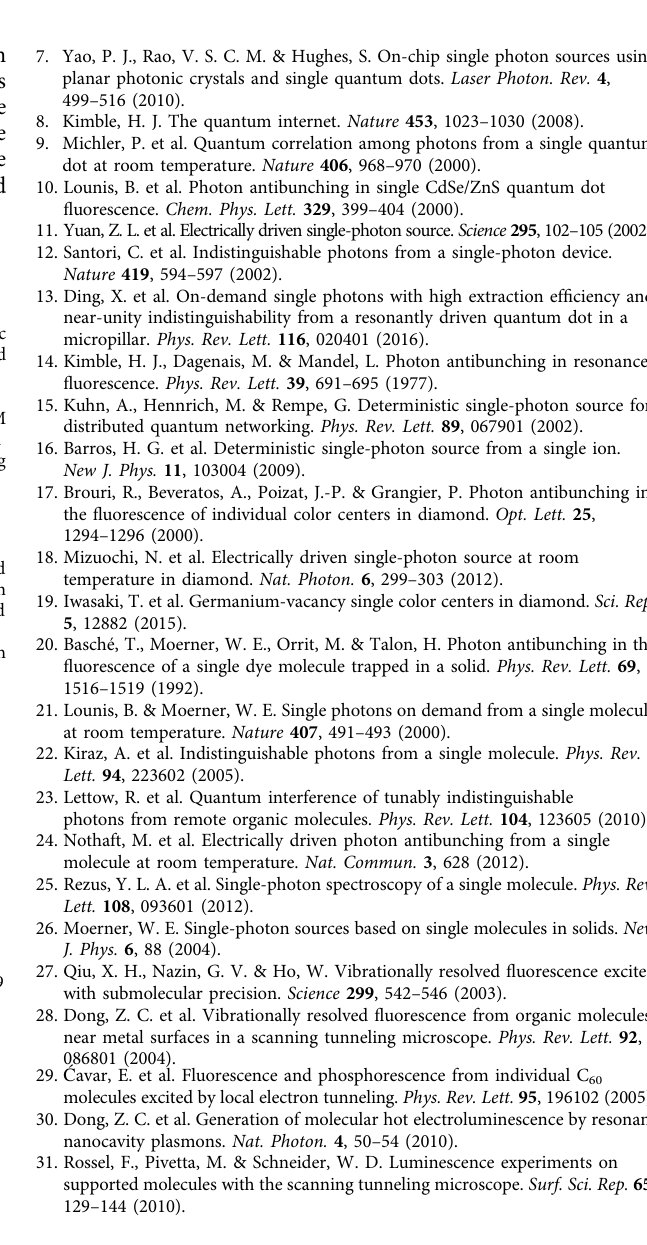
Fig. 6 Arti fi cially constructed single-photon emitter array. a Simultaneously acquired photon map ( top ) and STM image ( bottom ) of a 3 × 3 ZnPc molecular array on 3 ML NaCl through STM manipulation ( − 2.5 V, 50 pA, 14 × 14 nm 2 ). b , c STML spectra ( b , − 2.5 V, 300 pA, 10 s) and second-order correlation functions ( c , − 2.5 V, 300 pA) acquired from corresponding ZnPc molecules marked with numbers in a . The start (stop) counts for the correlation measurements are around 49 kHz (50 kHz) with an integration time of 1600